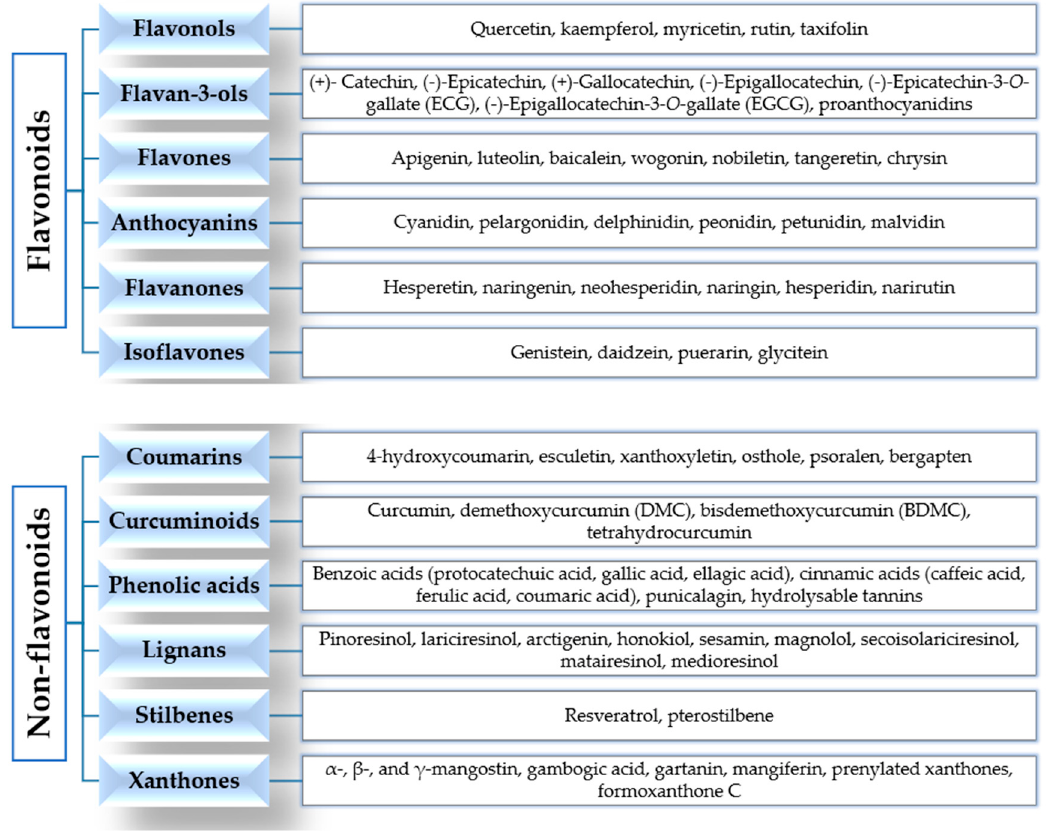
Figure 2. Classification of polyphenols.